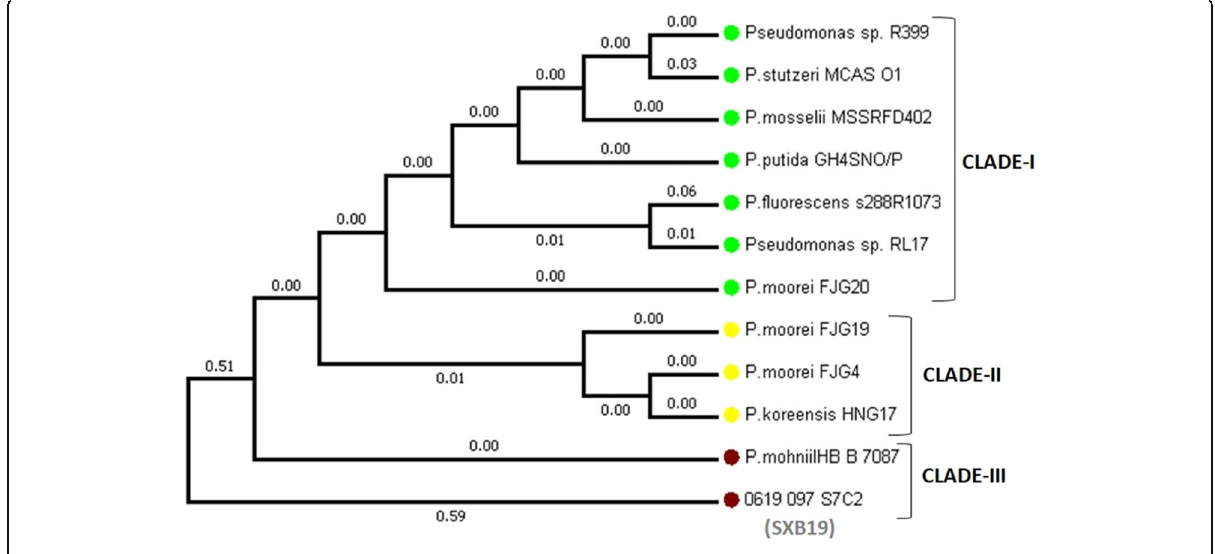
Fig. 4 Phylogenetic tree for the bacterial isolate SXB19